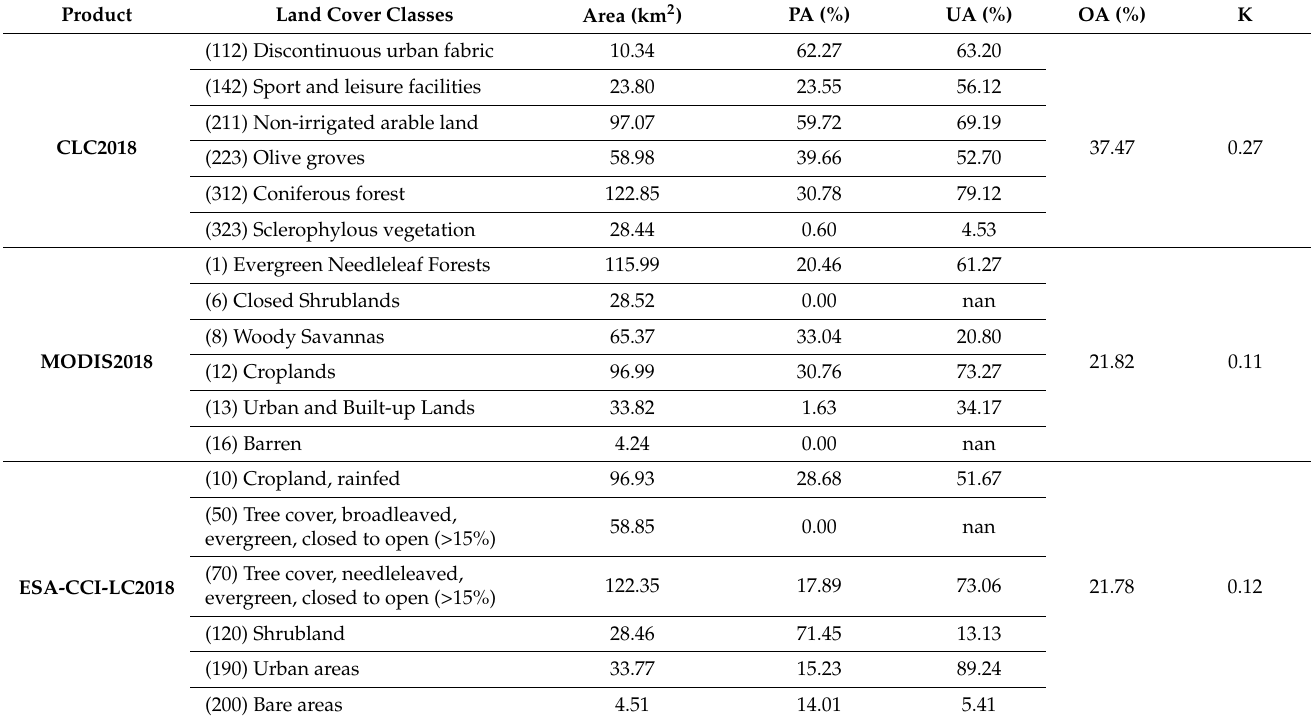
Table 5. Overall Accuracy (OA), Kappa Coefficient (K), User’s Accuracy (UA), and Producer’s Accuracy (PA) for the prevailing (exceeding 1% of the study area) land cover categories in Kassandra, for the three land cover datasets compared to the reference land cover